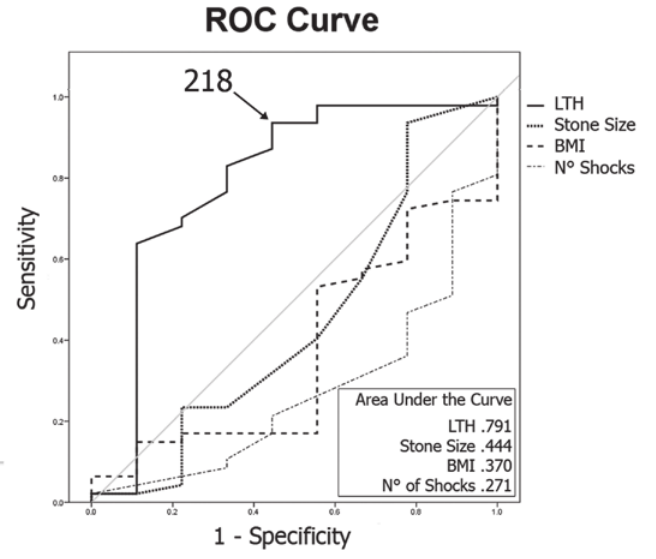
Figure 2 - Receiver operating characteristic